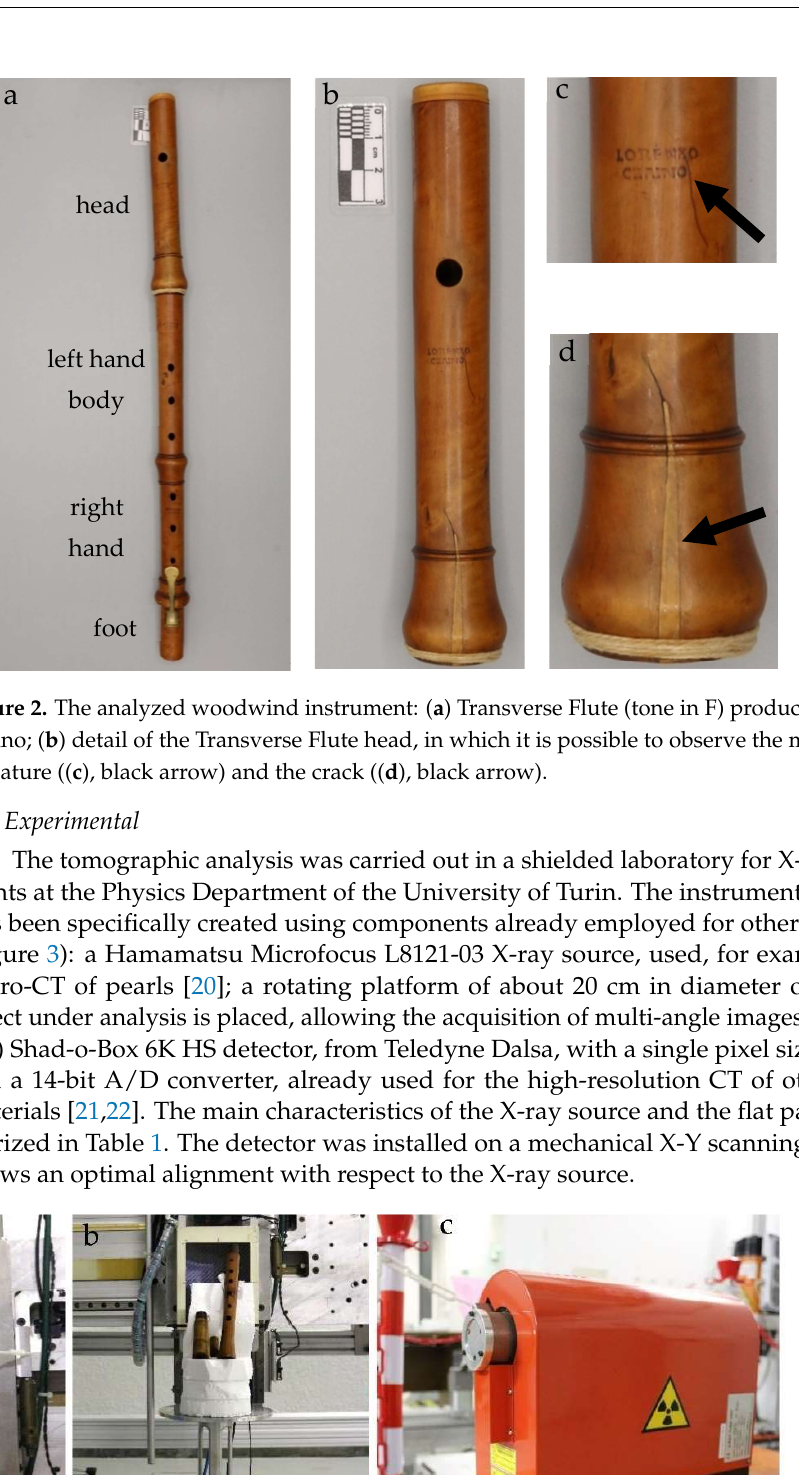
Table 1. Technical specifications of the equipment used.